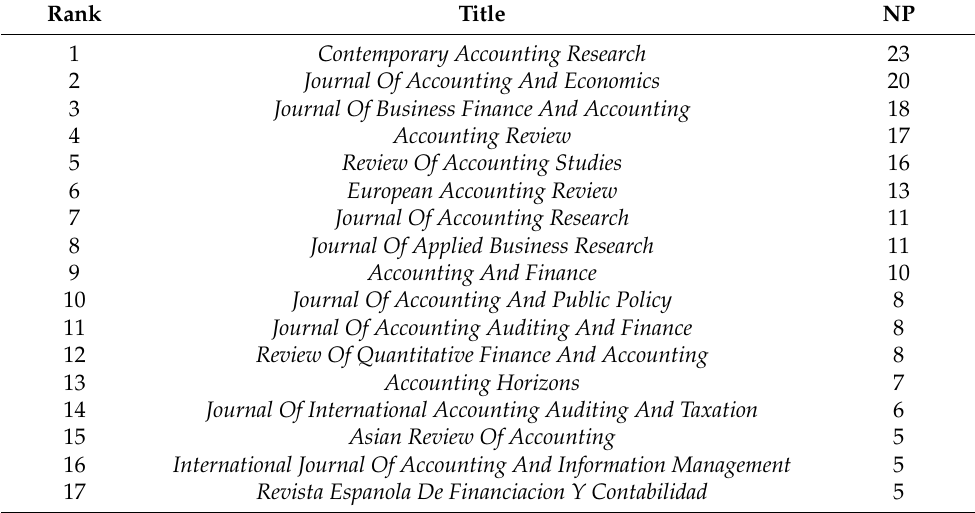
Table 4. Top productive journals that publish AC